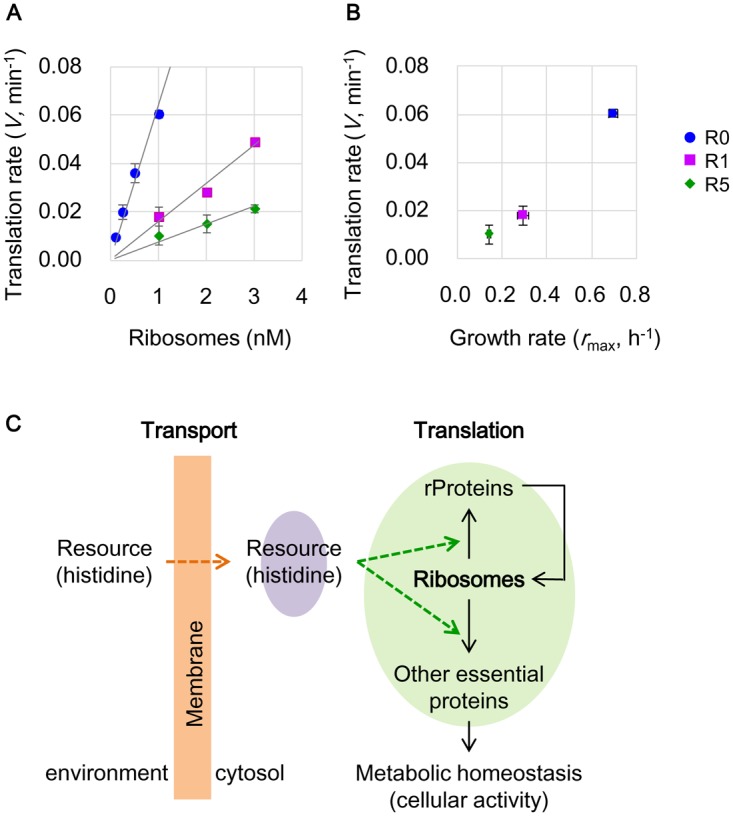
Relation between growth and translation.
A. Translation activity of ribosomes. The maximal translation rates of the purified ribosomes were estimated according to GFP biosynthesis curves. The ribosomes from R0, R1 and R5 are indicated in blue, purple and green, respectively. Solid lines indicated linear regressions with the slopes of 0.064, 0.016 and 0.007 for R0, R1 and R5, respectively. The standard errors of repeated tests (n = 3–4) are indicated. B. Correlation between growth rate and translation rate. The translation rates at 1 nM ribosomes (data from A) are plotted against the theoretically estimated maximal growth rates r
max (data from Fig 3C). Blue, purple and red represent R0, R1 and R5, respectively. Standard errors are indicated as described in A and Fig 3C. C. A scheme of the changes in the growth economics for maintaining cellular activity. The purple shading represents the intracellular resource (histidine) concentration balanced between incorporation (orange arrow) and consumption (green arrows). The green arrows indicate the changes in resource (histidine) redistribution for translation under poor conditions. The green shading highlights the reorganized protein translation enabling survival. The orange shading suggests the changes caused by the mutations related to membrane and transport, which required further demonstration and were excluded from the present study.